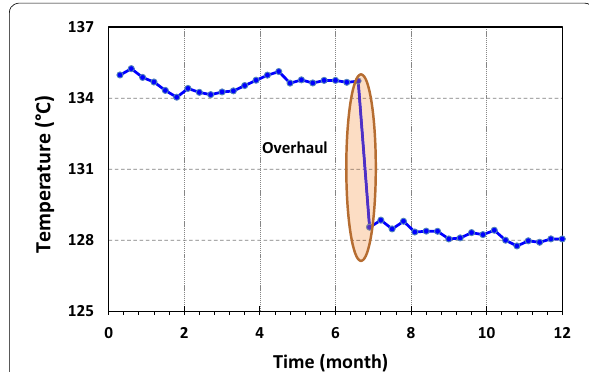
Fig. 4 Regenerator bottom temperature in gas sweetening unit. Overhaul: scheduled shutdown maintenance